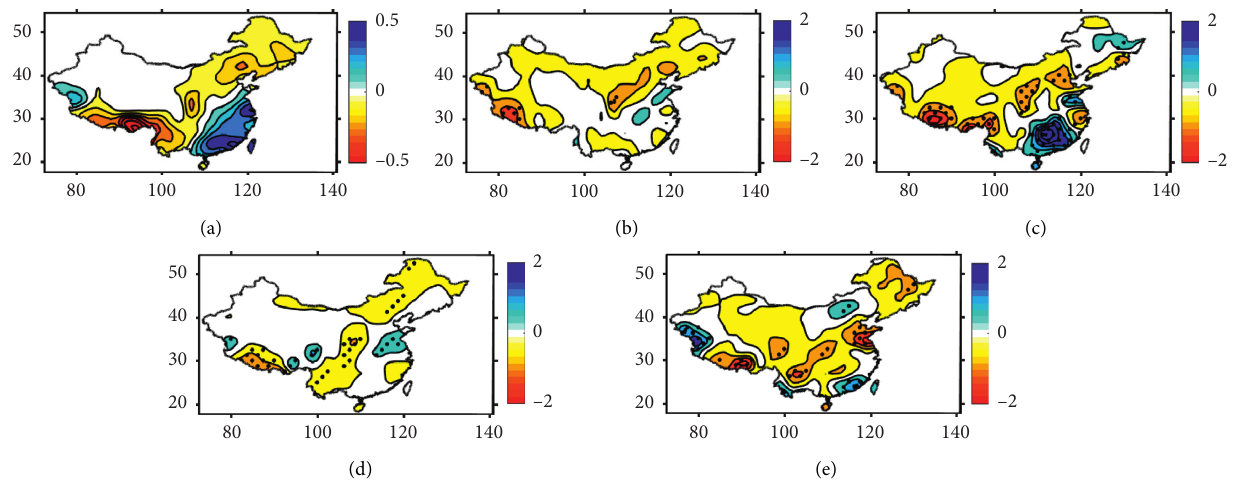
Figure 1: Composite precipitation (mm/day) for boreal summer (JJA) in (a) climate mean and four cases: (b) developing-cool PDO, (c) developing-warm PDO, (d) decaying-cool PDO, and (e) decaying-warm PDO. Signals above the 95% confidence level are highlighted by black